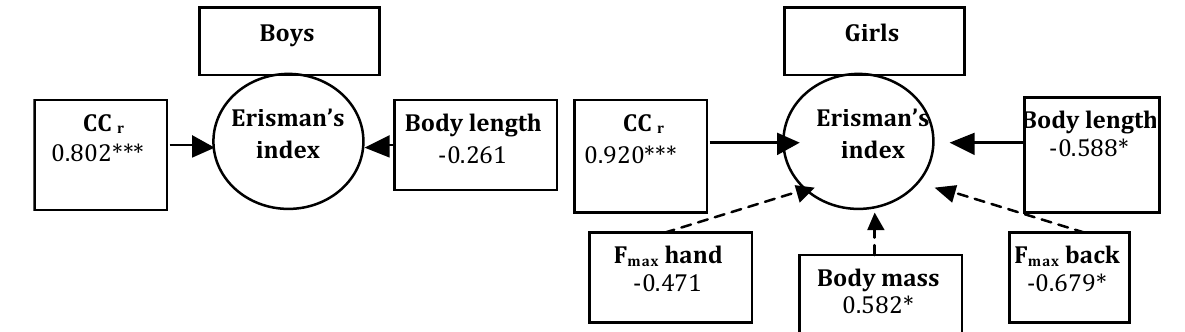
Fig.1. Interconnection of Quetelet’s index with somatologic indicators of students – members of biathlon sport- pedagogic perfection group. CC – chest circumference in rest; CC r circumference at exhale; indicators, which compose index; indicators, which influence on